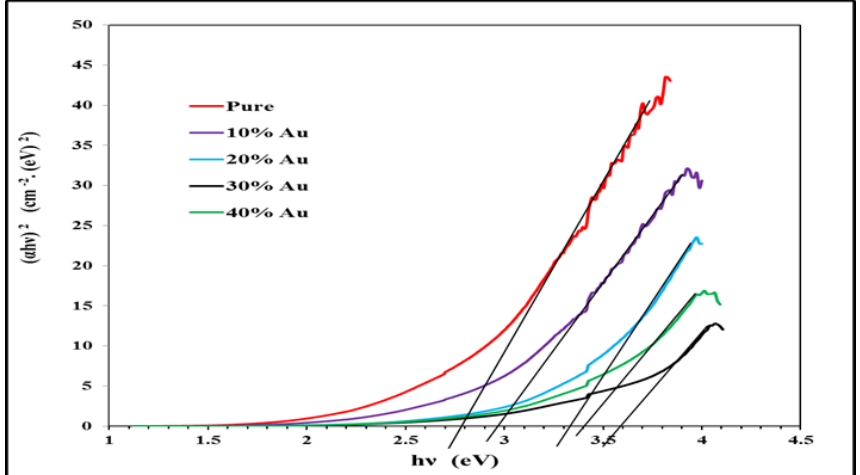
Fig. 9: The optical energy gap for pure WO